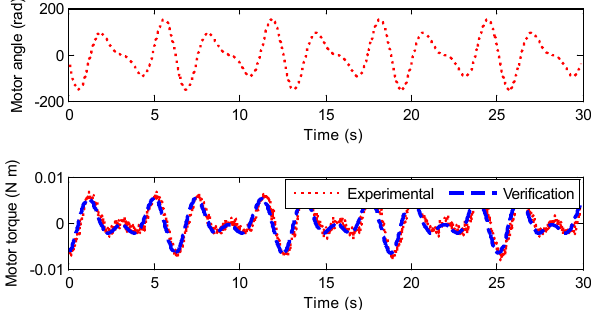
Figure 15. The verification experimental result of motor viscous damping.